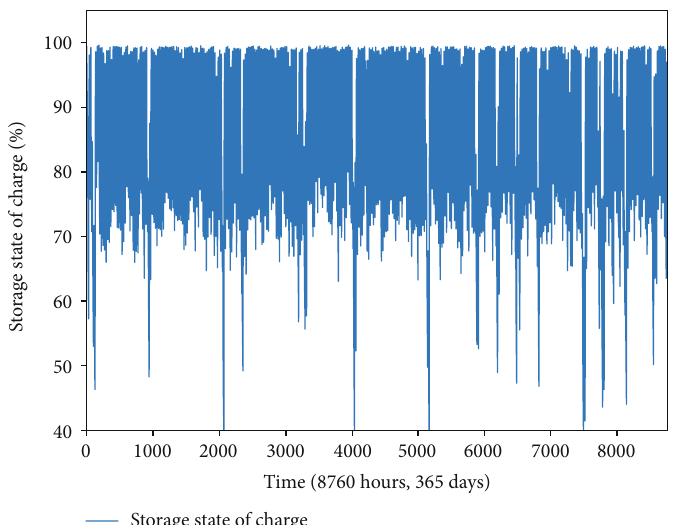
Figure 11: Storage charge state for the stand-alone PV